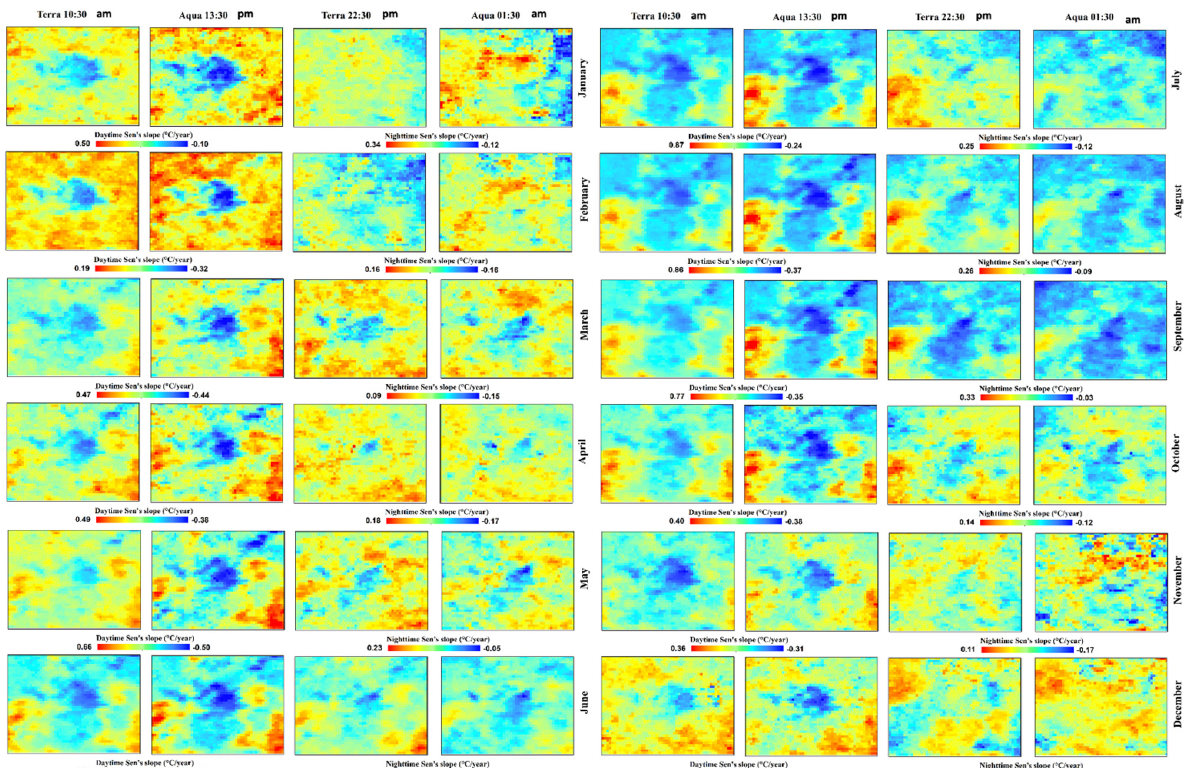
Figure 7. Monthly spatial variation of Sen’s slope trend of LST (average over 2003–2019) during daytime (Terra 10:30 a.m. and Aqua 13:30 p.m.) and nighttime (Terra 22:30 p.m. and Aqua 01:30 a.m.) from January to